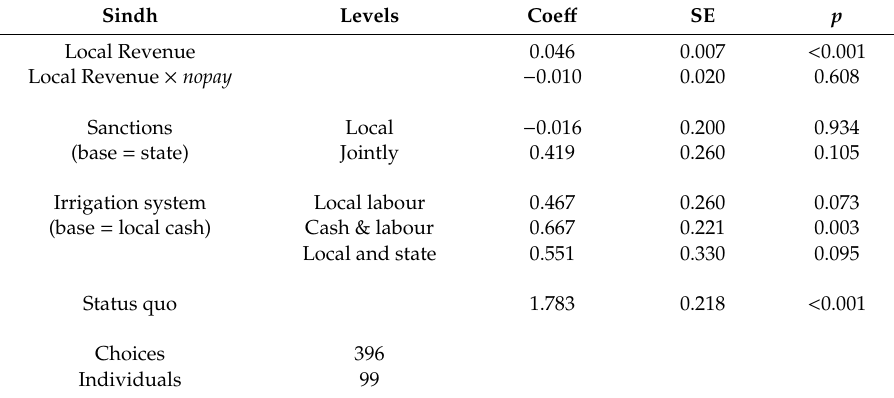
Table 14. Conditional logit estimates for preferences for governance structures: